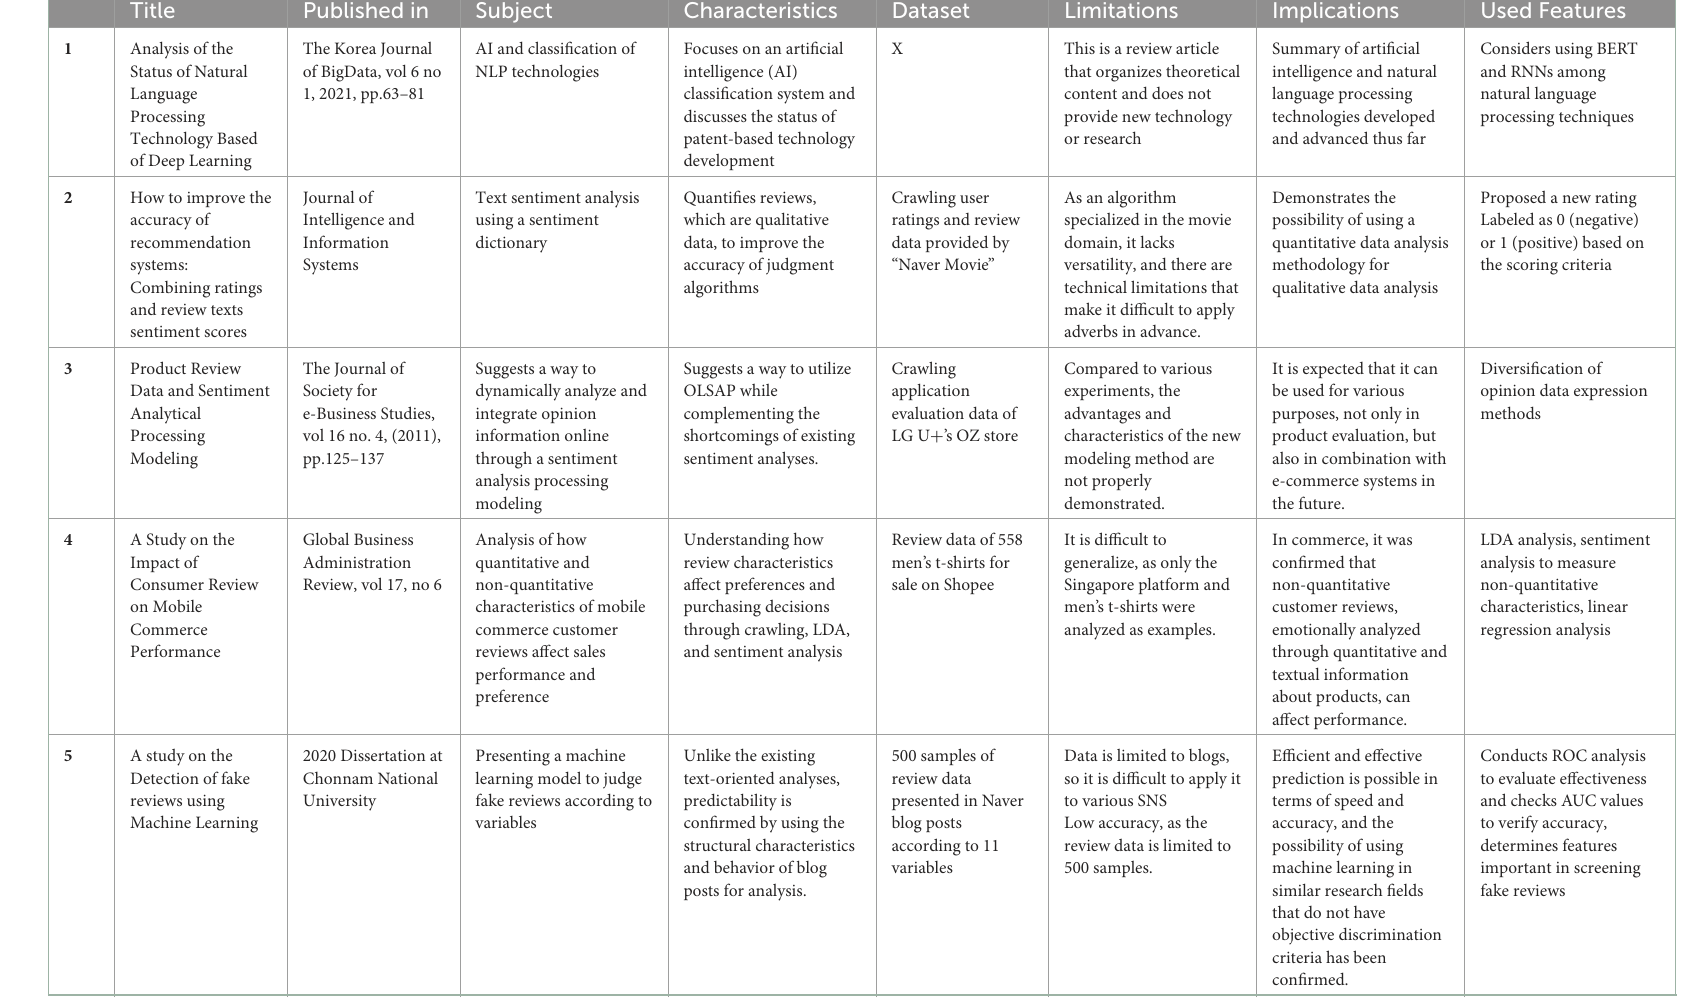
TABLE 1 Prior studies used in this